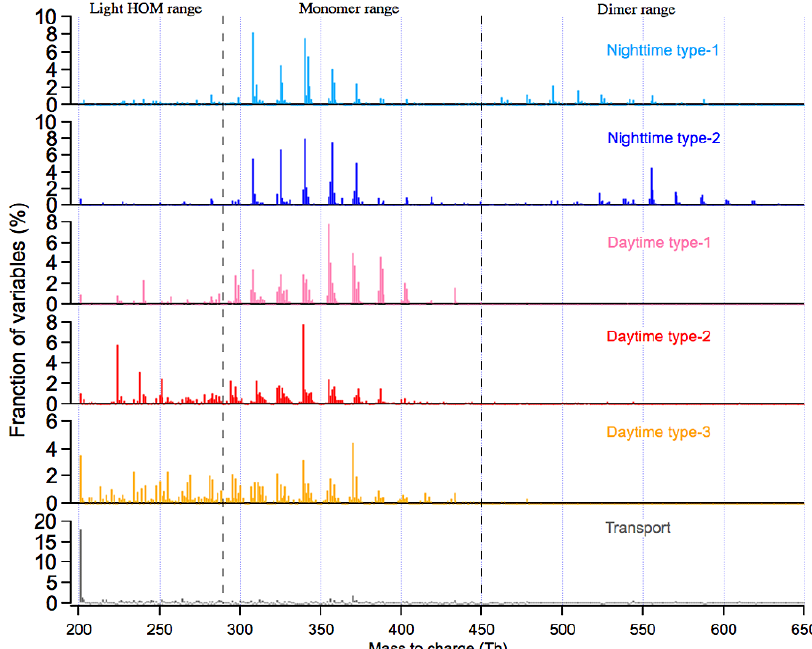
Figure 5. Factor profiles in six-factor PMF. The total signal of each factor is normalized to unity, and y axis is the fraction of variables in the factor in